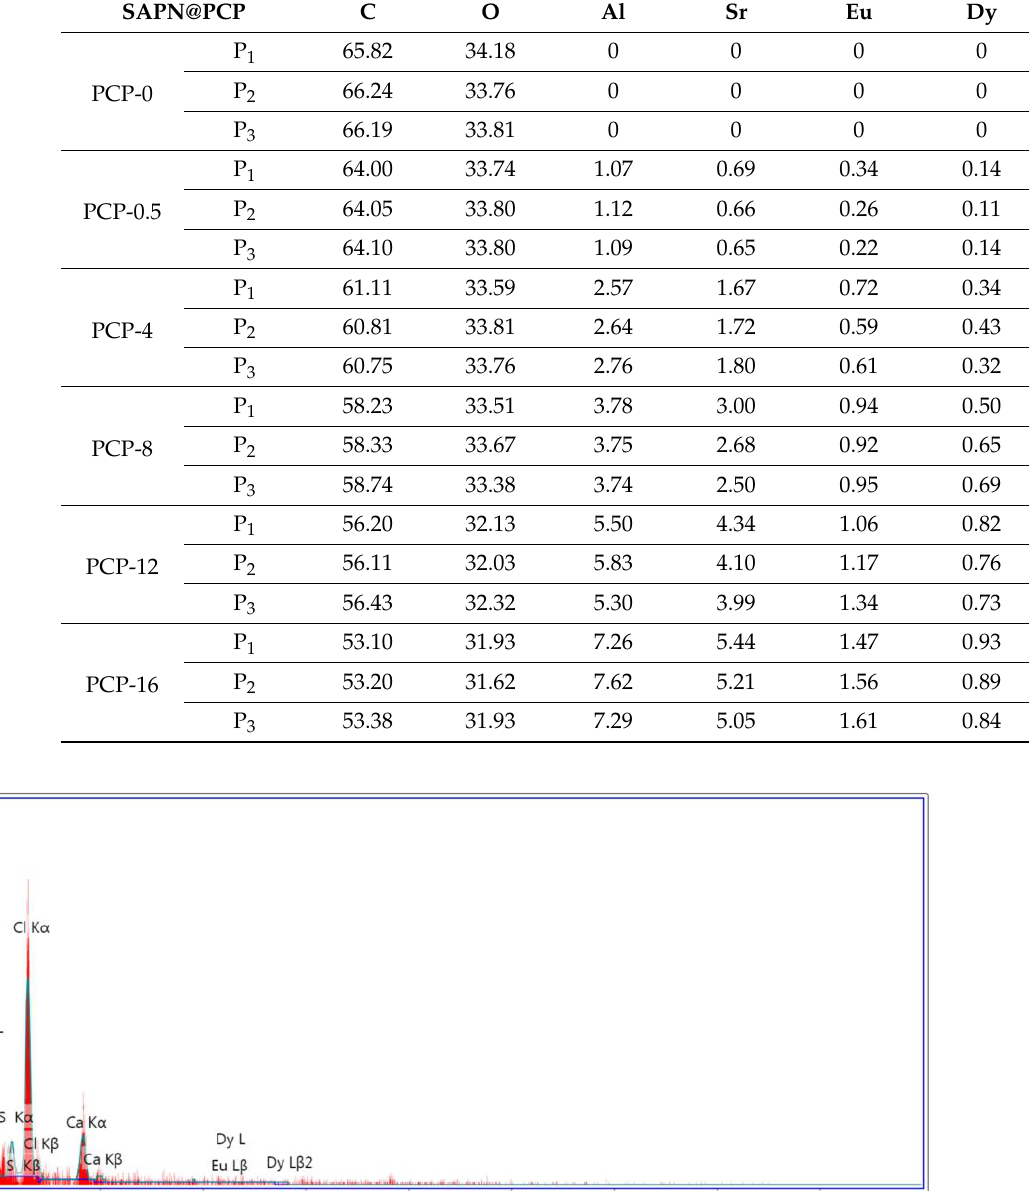
Table 1. Elements (wt%) monitored by EDX of SAPN@PCP at three separate points (P 1 , P 2 and P 3 ).